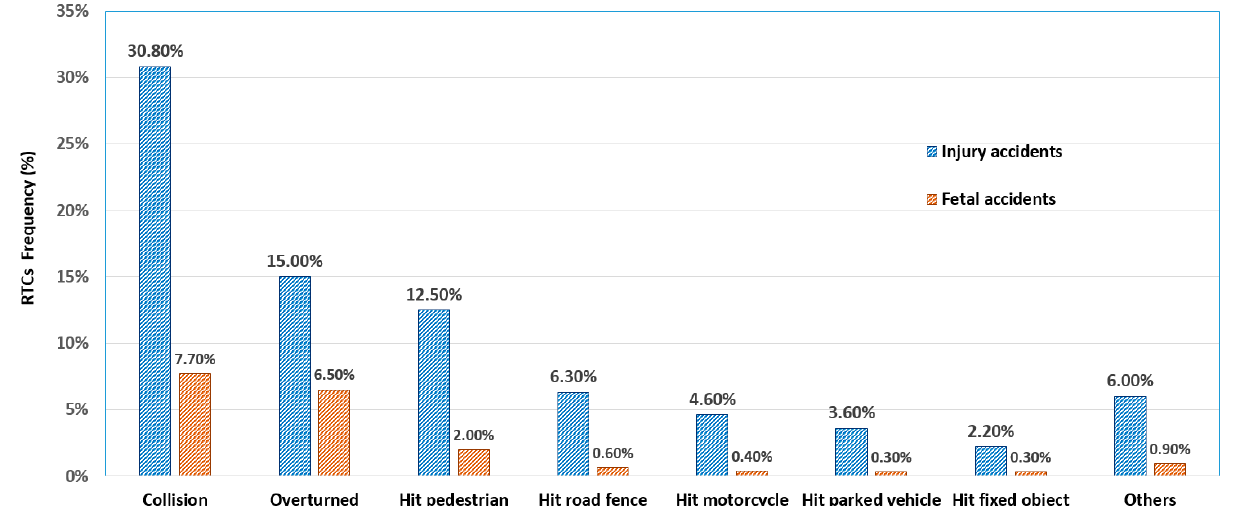
Figure 1. Study area and locations of traffic crashes in the Al-Ahsa region of Saudi Arabia (adopted from [51]).